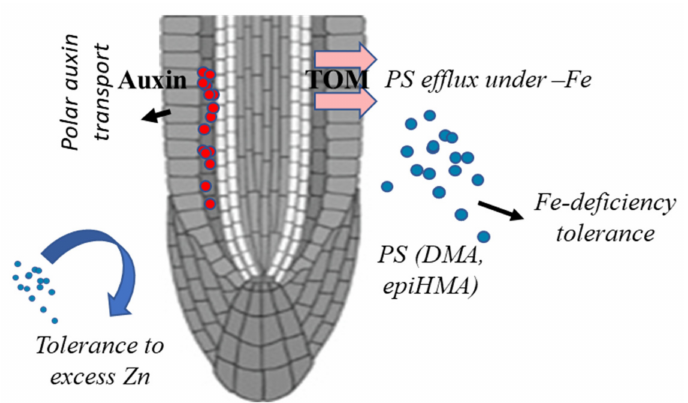
Figure 3. Root-specific functions of plant ZIFL transporters. The ZIFLs (TOMs) are involved in PS secretion in the rhizosphere to mobilize divalent cations with their extended function also in auxin homeostasis and tolerance to excess Zn. The colored round dots indicate auxins (red) and phytosiderophores (blue), such as deoxymugineic acid (DMA) and 3-epihydroxymugineic acid (epiHMA). The ZIFLs also provide tolerance to heavy metals (Ni, nickel; and Cd, cadmium) and excess zinc (Zn)